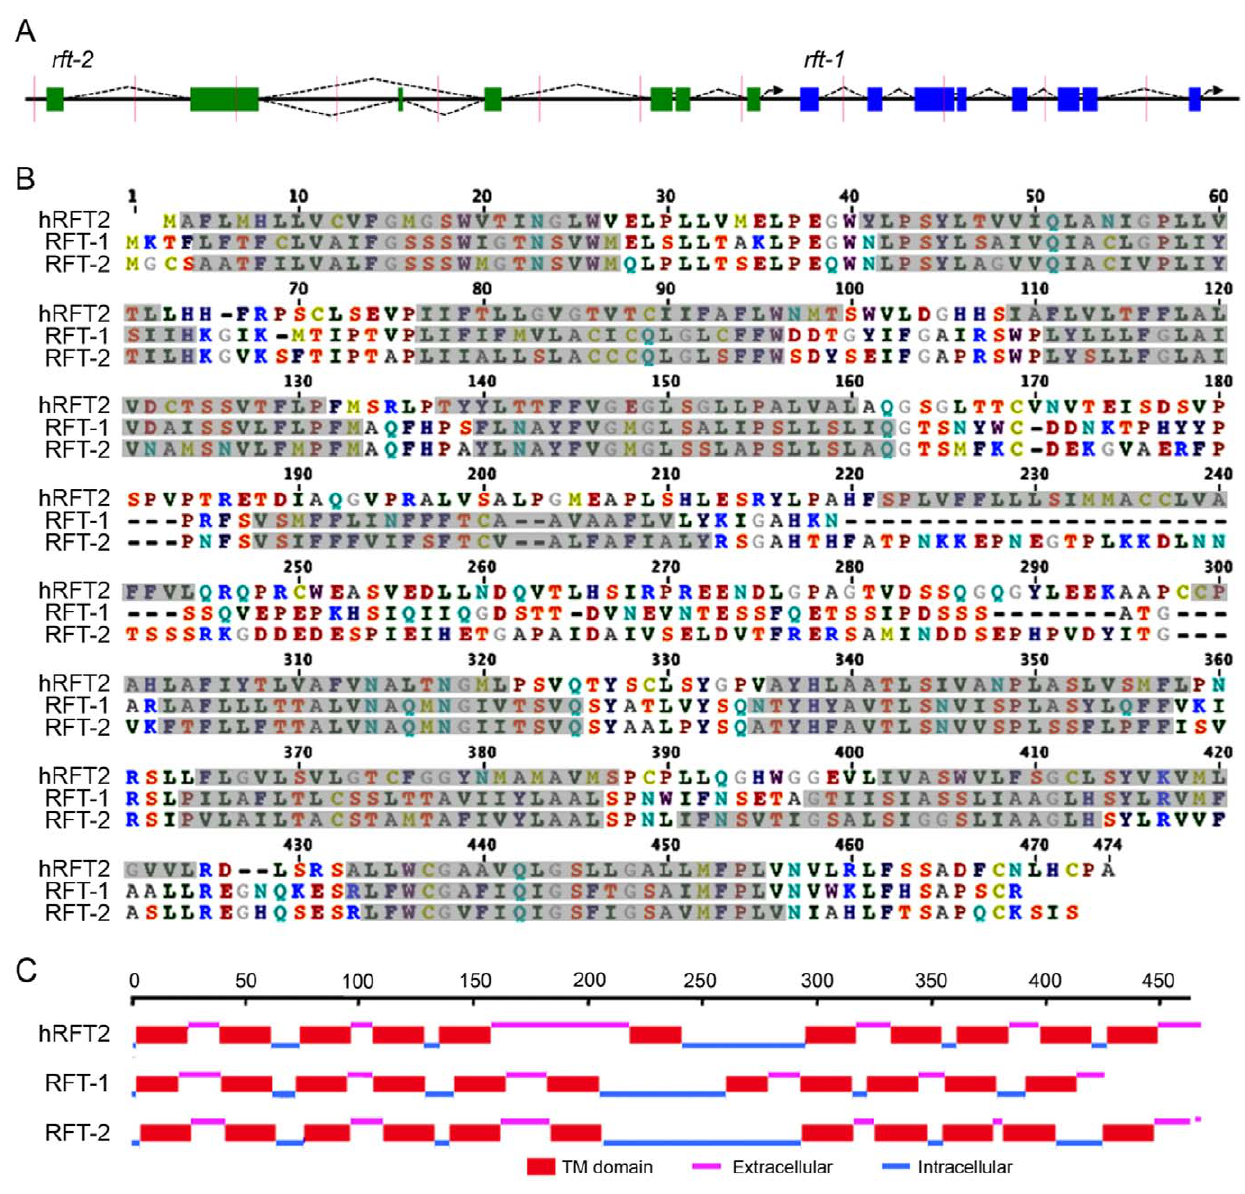
Figure 1. Exonic and protein structure of riboflavin transporters. (A) The tandem arrangement of rft-1 and rft-2 on chromosome V. Note that rft-2 is alternatively spliced. Hash marks along the chromosome indicate 1,000 bp intervals. (B) Amino acid alignment of rft -1, rft -2, and the putative human homolog, hRFVT3. Shaded regions indicate predicted transmembrane domains. (C) The locations of the transmembrane domains and intracellular and extracellular loops. The numbered bar indicates amino acid position.